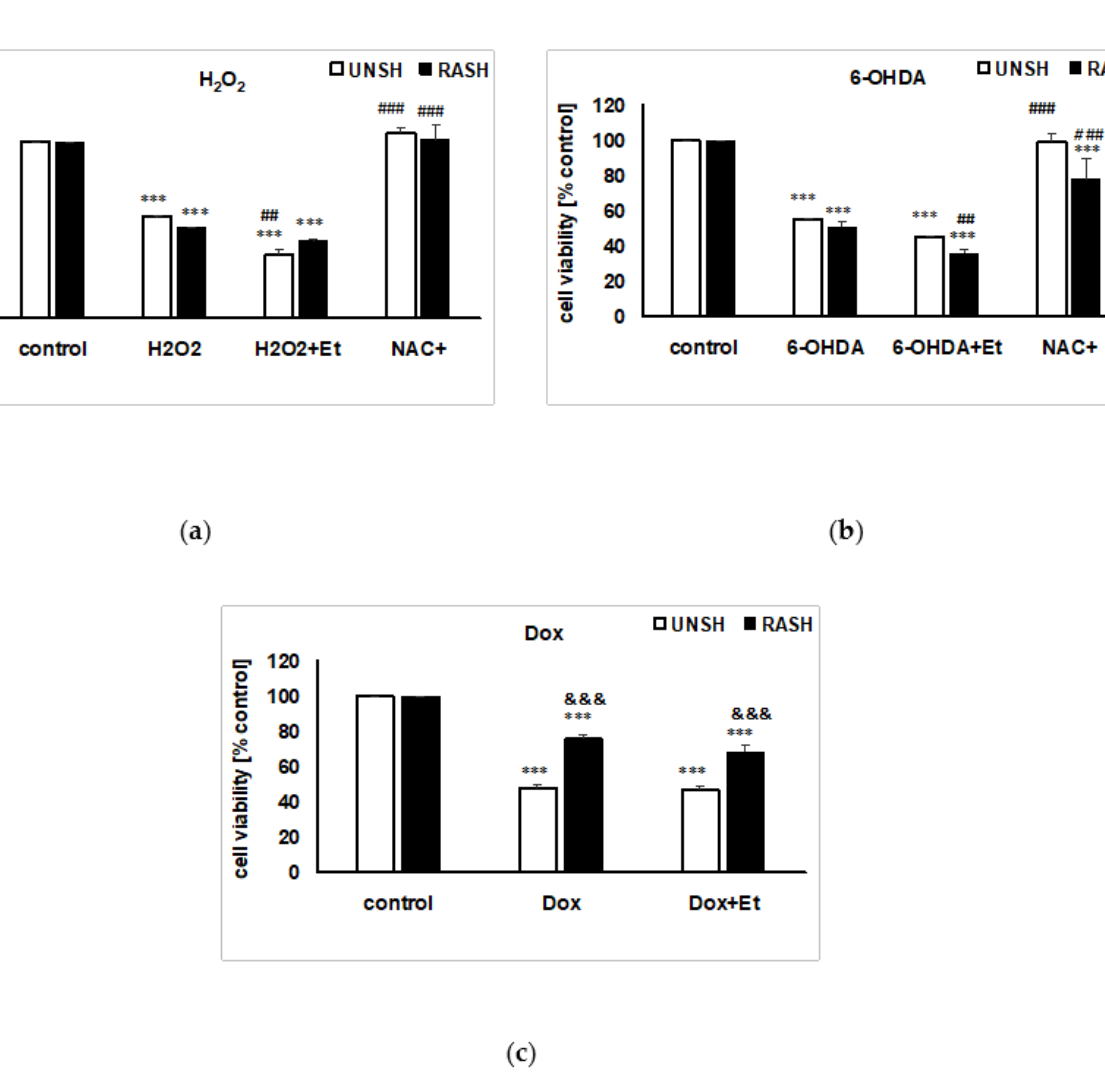
Figure 4. The impact of vehicle (0.7% ethanol) and antioxidant N-acetylcysteine (NAC, 1 mM) on cell damage induced by: ( a ) hydrogen peroxide (H 2 O 2 ); ( b ) 6-hydroxydopamine (6-OHDA) and ( c ) doxorubicin (Dox) in UN- (UNSH) and RA-SH-SY5Y (RASH) cells. Statistical analysis was done with two-way ANOVA. Cell viability was measured with WST-1 assay and the data were normalized to the vehicle-treated cells and presented as the mean ± SEM from 4–5 independent experiments with three repetitions. ** p < 0.01 and *** p < 0.001 vs. vehicle-treated cells; ## p < 0.01 and ### p < 0.001 vs. toxin-treated cells; &&& p < 0.001 UN- vs. RA-SH-SY5Y